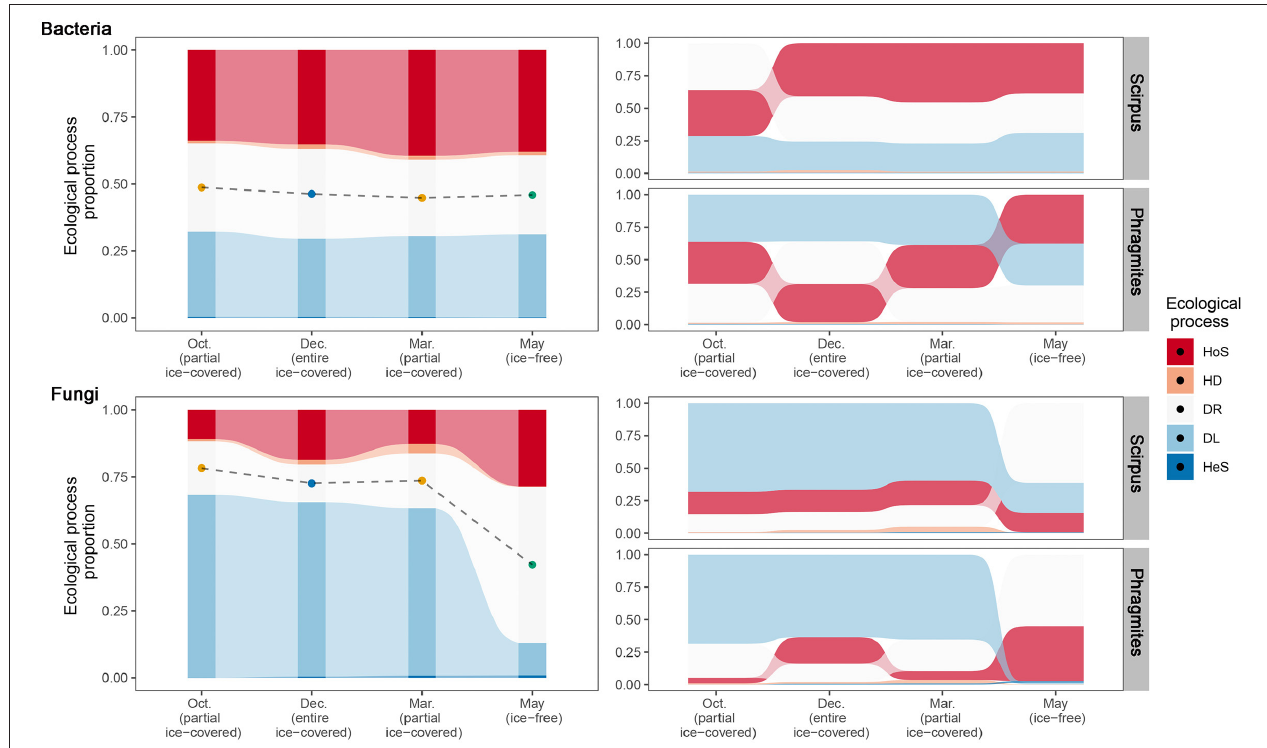
FIGURE 3 | Relative importance of different ecological processes to bacterial and fungal communities across different ice-covered stages and plant species. Different fill colors indicate different community assembly processes: HoS, homogeneous selection; HD, homogeneous dispersal; DR, ecological drift (i.e., undominated processes, including drift, diversification, weak selection, and/or weak dispersal); DL, dispersal limitation; HeS, heterogeneous selection. In the two left sub-figures, points depict the midpoint of the ecological drift process and reflect the deviation compared to the null model. In the two sub-figures on the right, processes were ranked according to the relative importance (proportion) from top to bottom to reflect the turnover of dominant processes across different ice-covered stages.